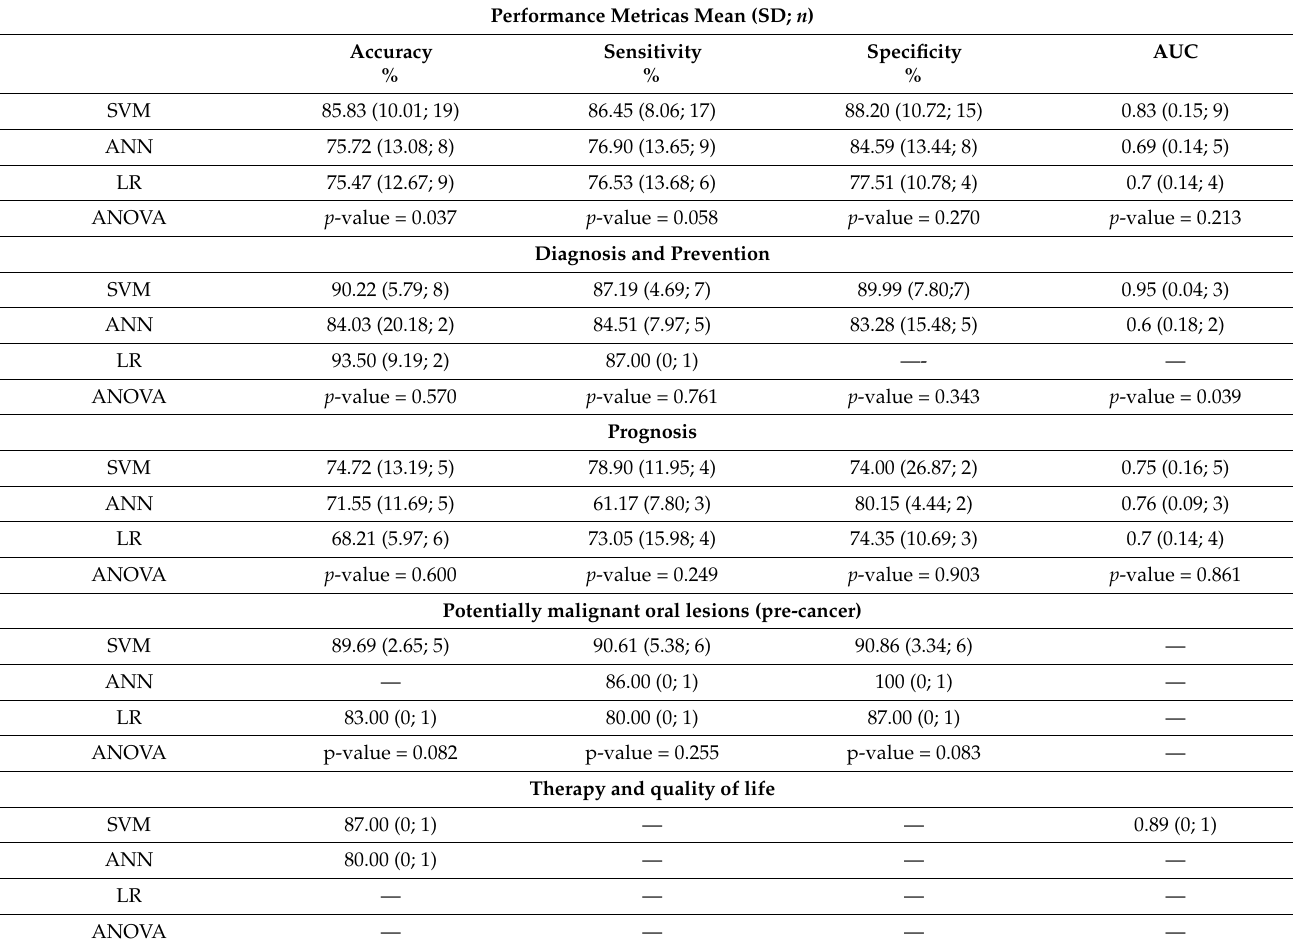
Table 2. Statistical comparisons of reported performance metrics for support vector machine, neural network, and logistic regression algorithms. Metrics are shown according to the clinical contexts (diagnosis and prevention, prognosis, pre-cancer, and therapy and quality of life).